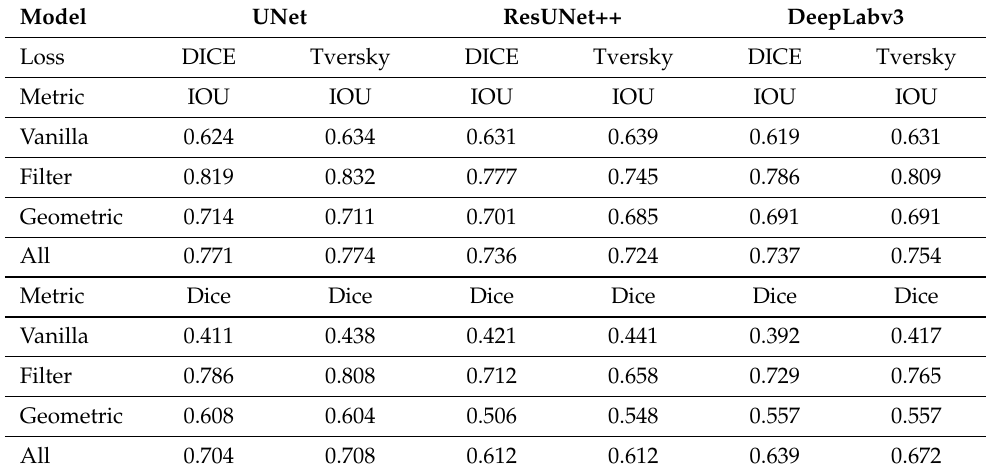
Table 4. The performance according to various data augmentation techniques in augmented X-ray datasets.